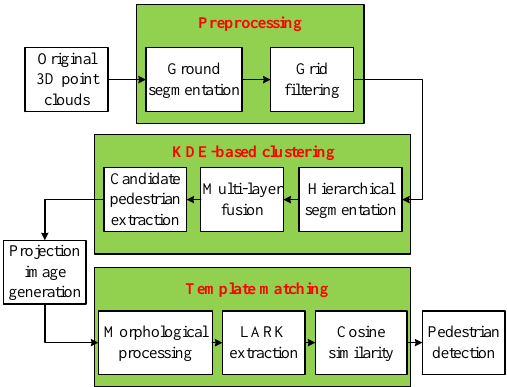
Figure 1. Flowchart of pedestrian